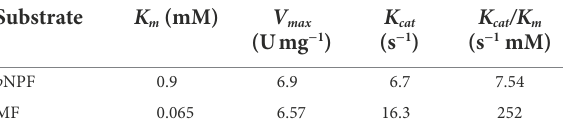
TABLE 1 Kinetic parameters of Lb FAE determined against the p NPF and MF. Substrate